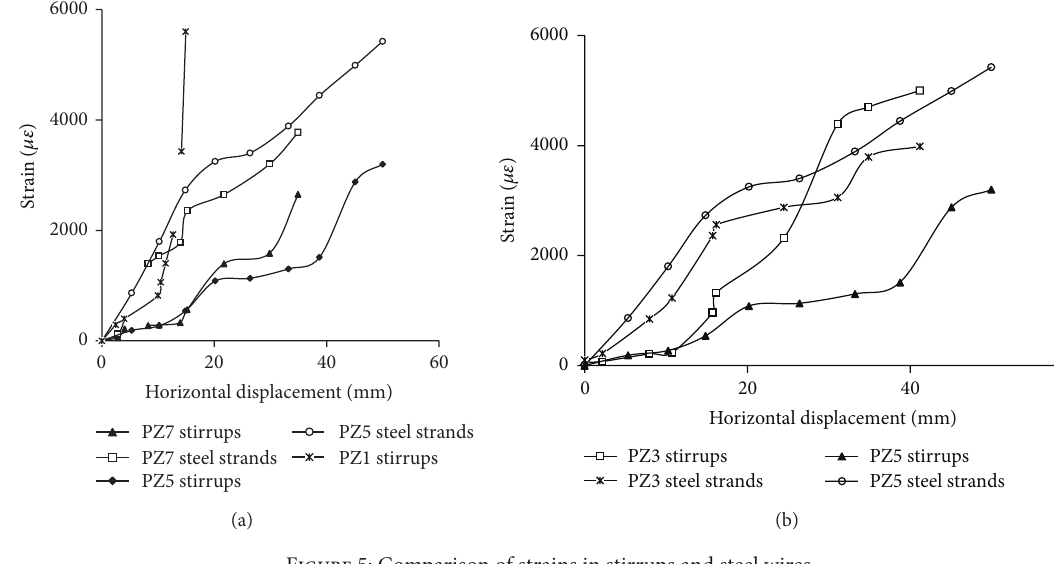
Figure 5: Comparison of strains in stirrups and steel